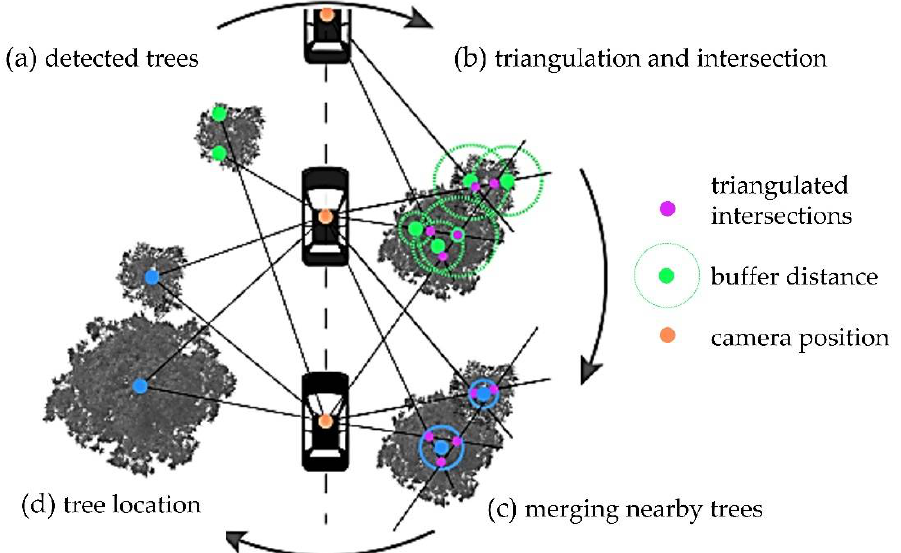
Figure 6. Graphical summary of stage 1A to perform individual tree detection based on the use of computer vision on Google Street View